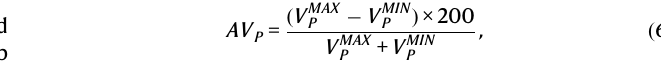
where σ ij refers to the stress tensor, ε kl refers to the strain tensor, and C ijkl represents the fourth-order elastic modulus. For the hcp